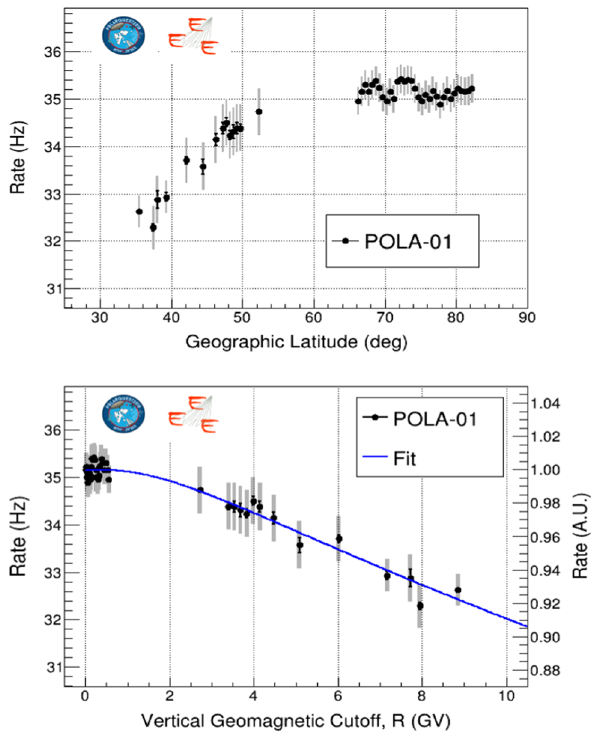
Fig. 9 Cosmic particle rate measured by the POLA-01 detector as a function of the geographic latitude (top panel), and as a function of the vertical geomagnetic cutoff (bottom panel)